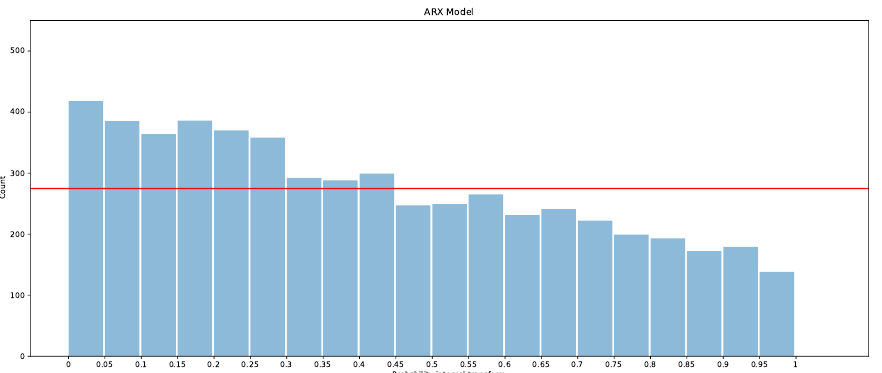
Figure A5. PIT for the X-model for the entire test set.